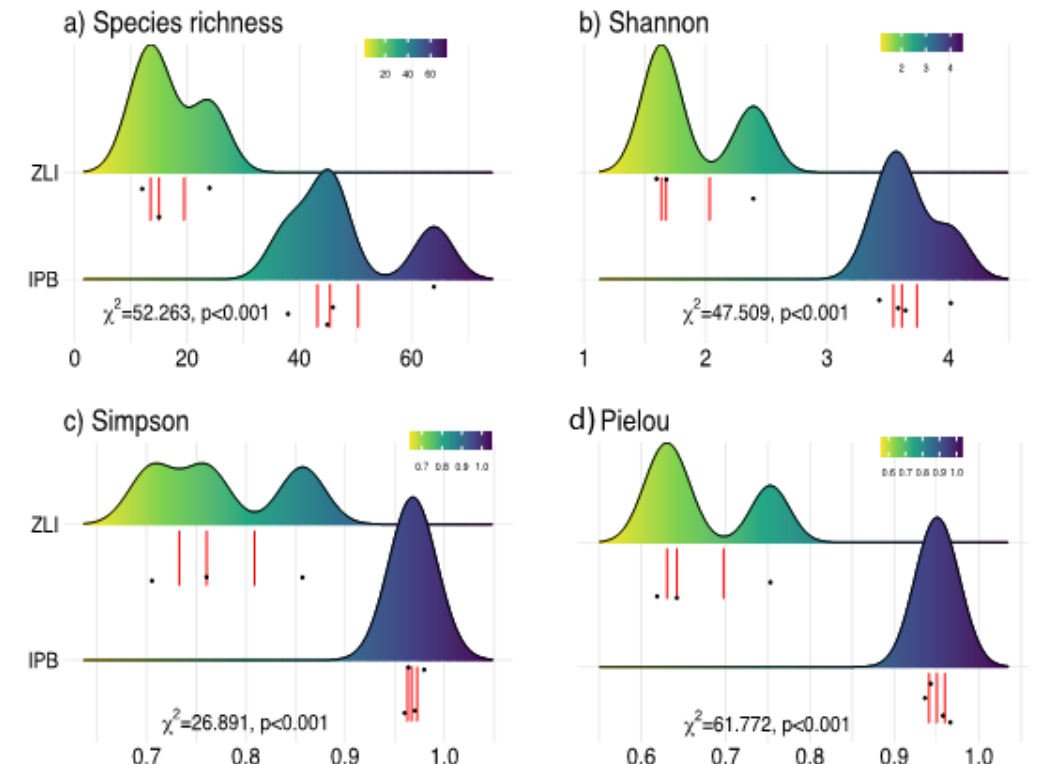
Figure 7. Variation of diversity indexes between the two plant communities evaluated in Himalayan Subtropical-Temperate Ecotone/Evergreen Oak Forest (GLM results, and associated p -values are displayed at each plot). ( a – d ), Relationship between species richness ( a ), Shannon diversity ( b ), Simpson diversity ( c ), and Pielou’s evenness ( d ) in relation to two plant communities based on the stand’s values. X -axis is displayed in ascendant altitudinal gradient.